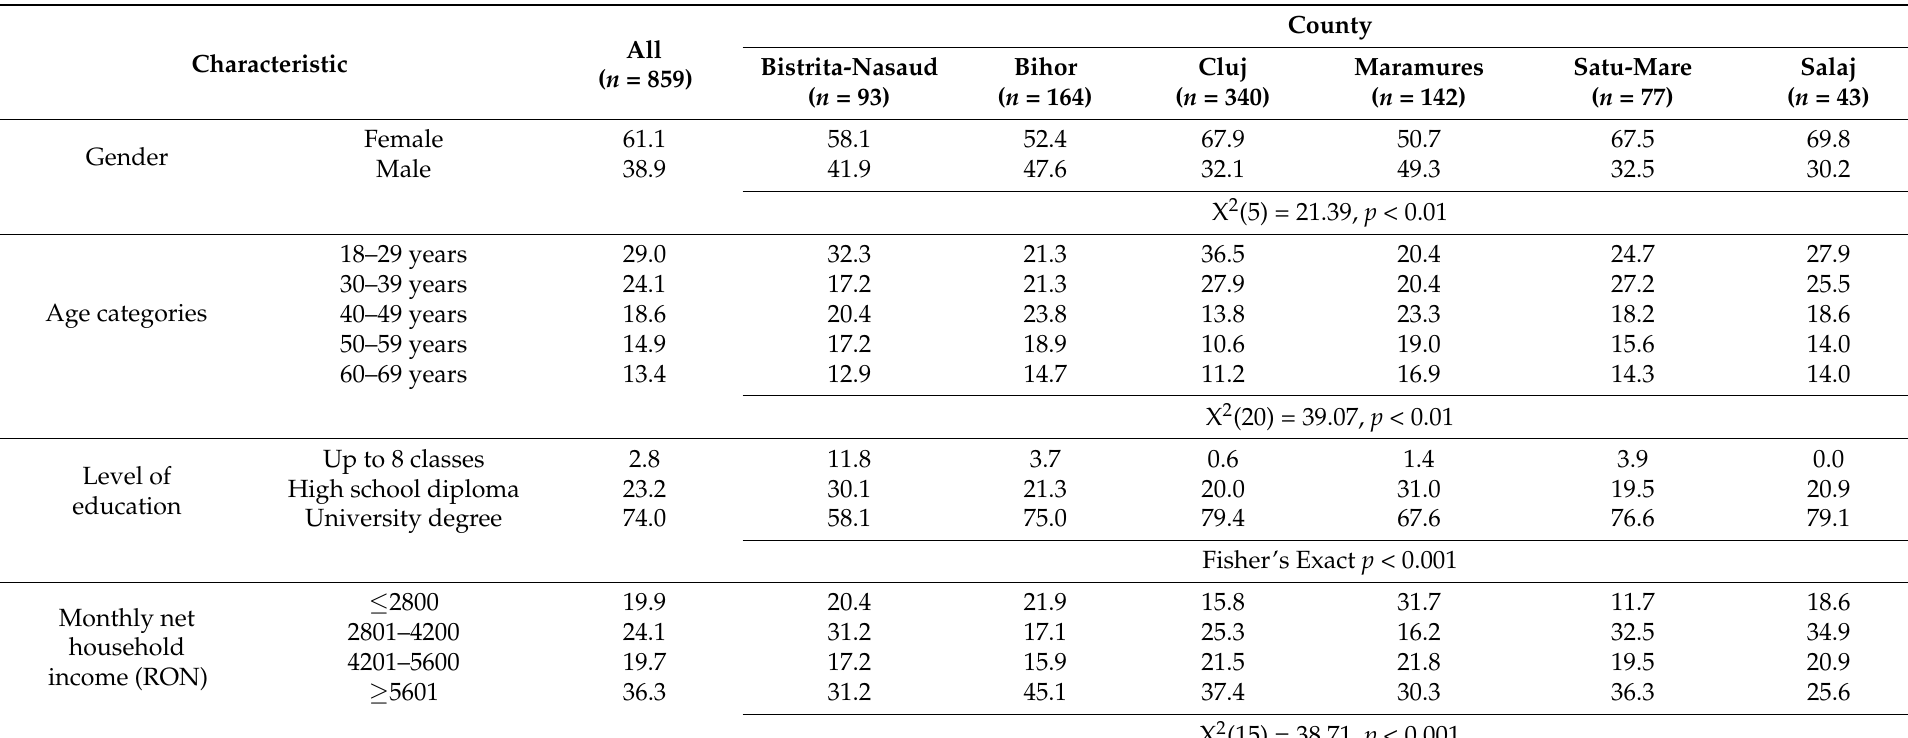
Table 1. Socio-demographic characteristics of the sample